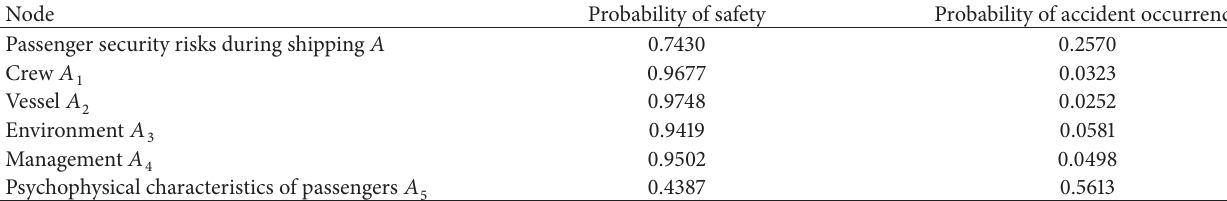
Table 12: Safety probability of Passenger